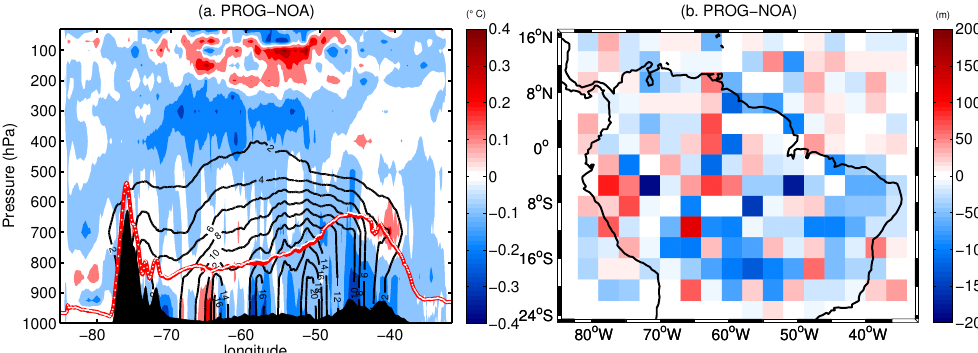
Figure 6. (a) Differences in potential temperature (coloured) and BBA mass mixing ratio (ngg − 1 , black contours) averaged over 10–13 ◦ S for the entire campaign period at 18:00UTC for PROG-NOA. Red and white lines are boundary layer depth of PROG and NOA respectively. Topography is masked black. (b) Differences in BL height